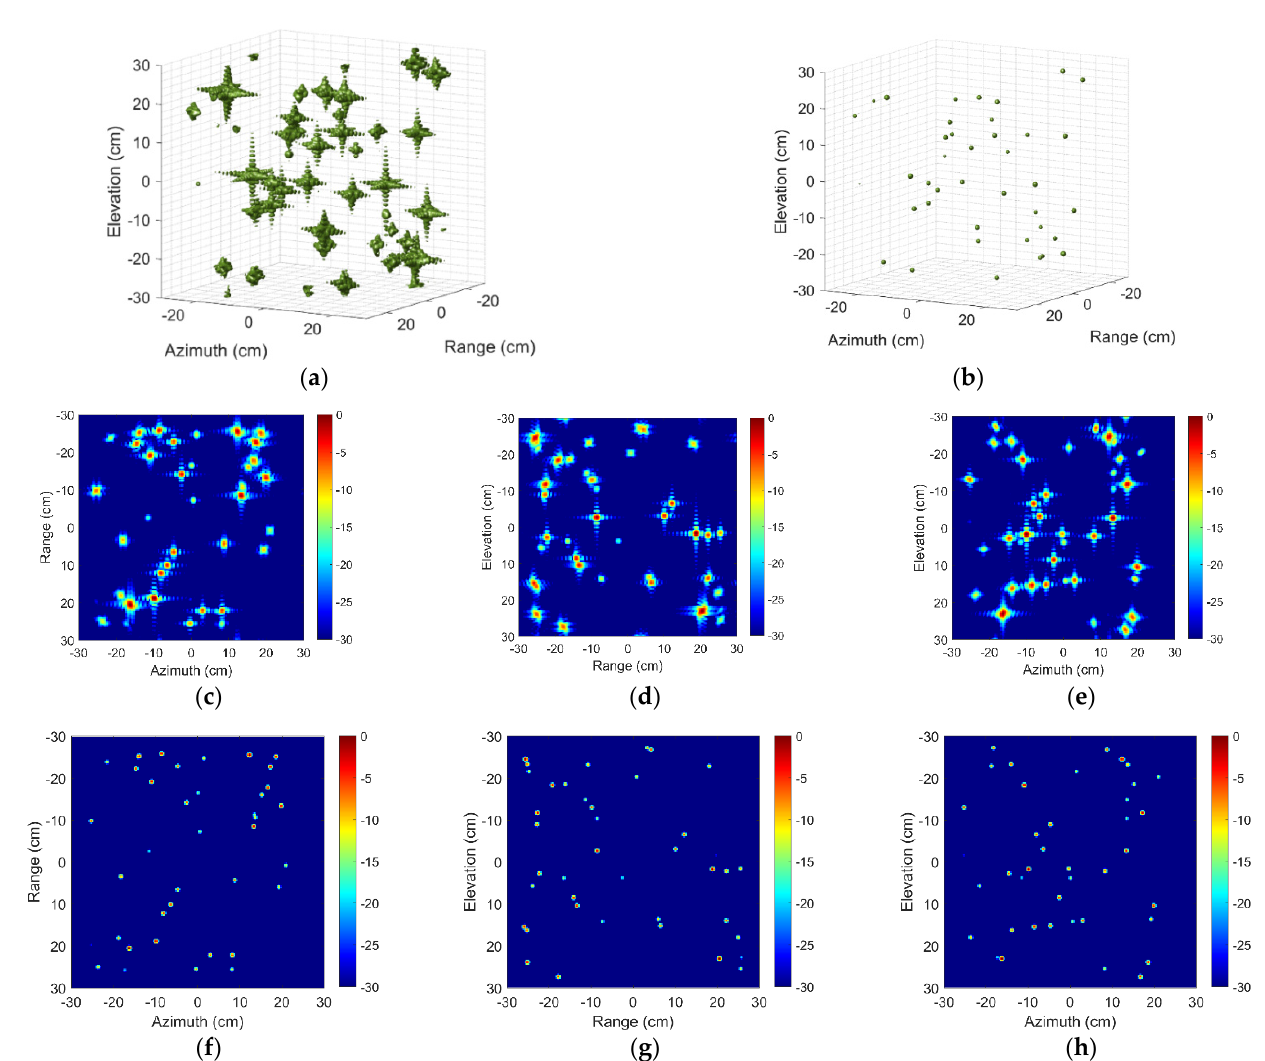
Figure 4. Three − dimensional images and two − dimensional image profiles of the input and output sample. Three − dimen- Figure 4. Three-dimensional images and two-dimensional image profiles of the input and output sample. Three-dimensional sional image of ( a ) Input and ( b ) Output sample. Two − dimensional image profiles of ( c − e ) Input and ( f − h ) Output sample. image of ( a ) Input and ( b ) Output sample. Two-dimensional image profiles of ( c – e ) Input and ( f – h ) Output